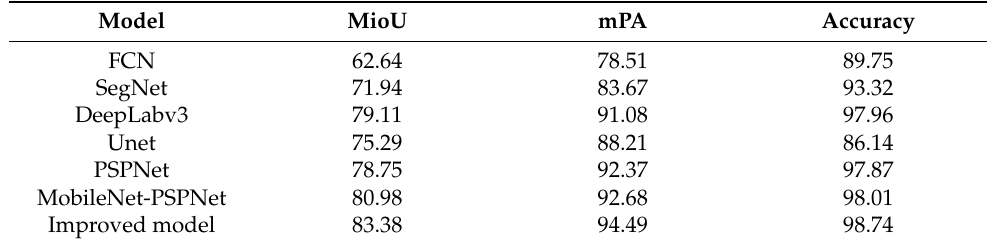
Table 4. Performance comparison of the different